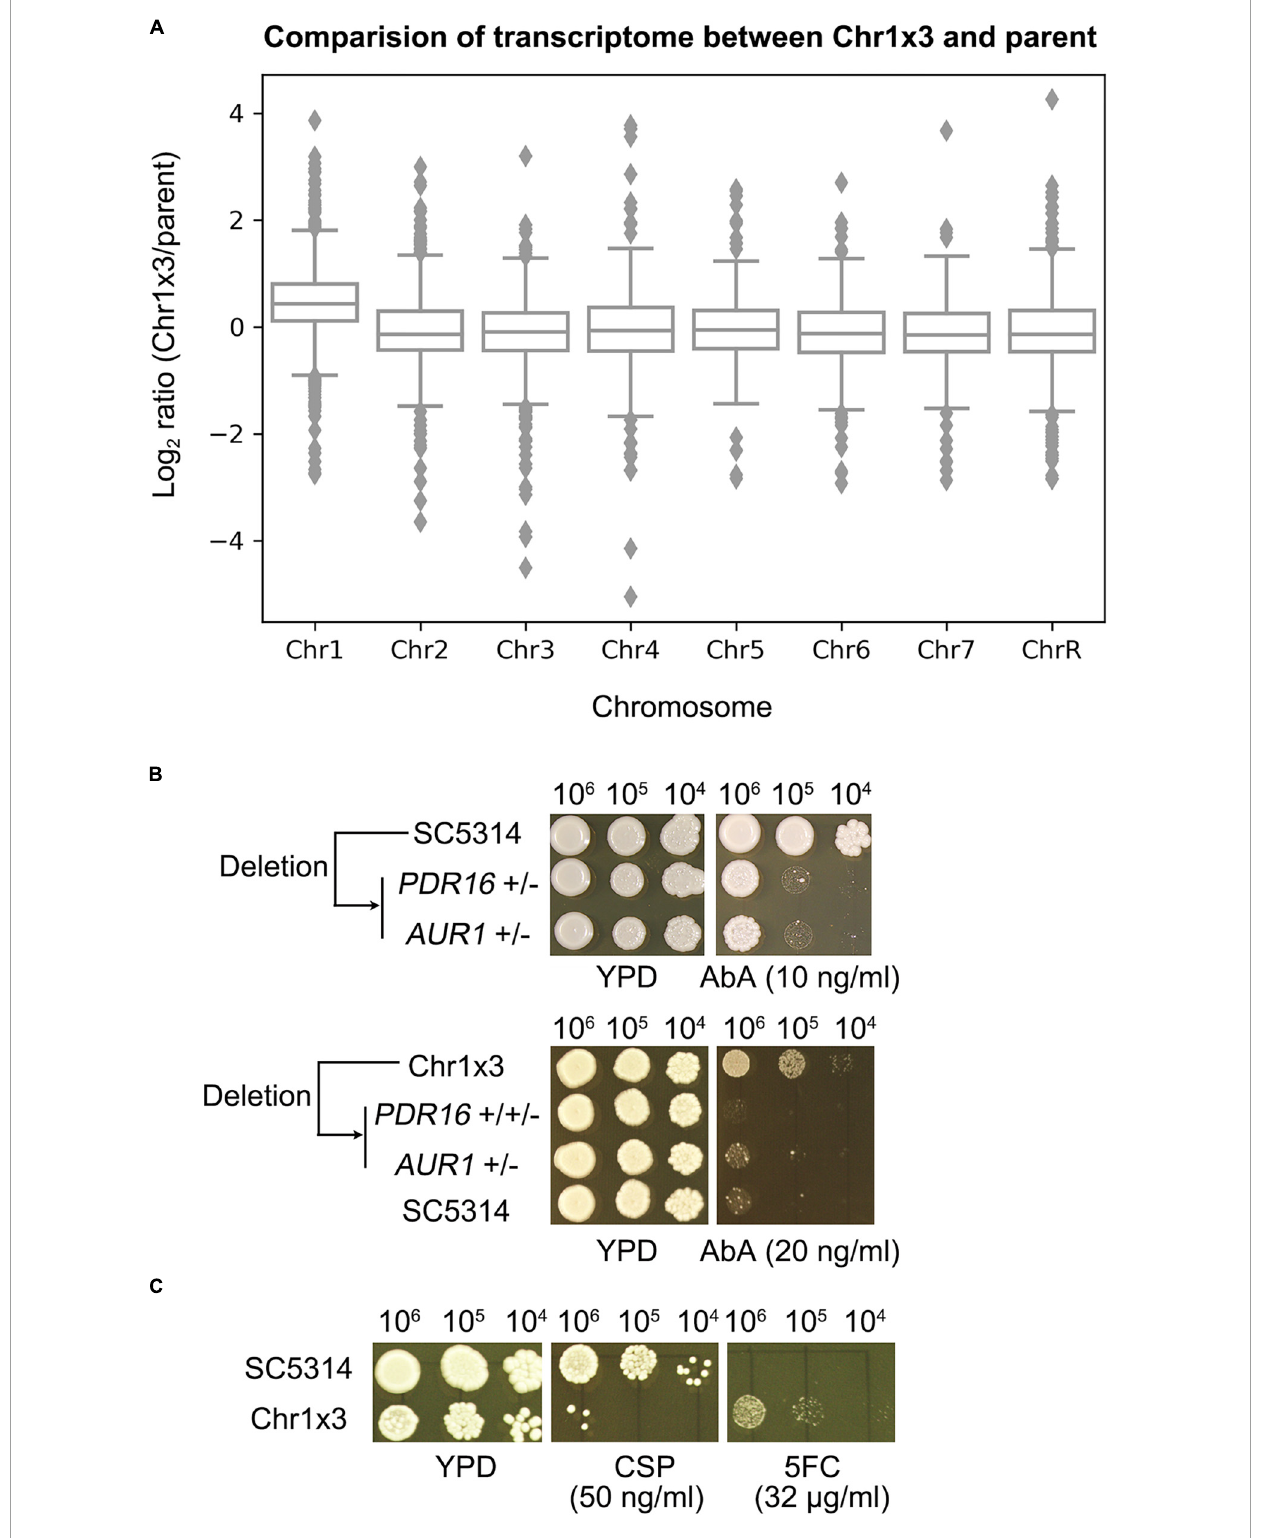
FIGURE4 Chromosome 1 trisomy has pleiotropic effect on whole genome transcription and antifungal resistance profile. Transcriptome of one Chr1 trisomy mutant was compared to the diploid wild type strain. Cells were grown on YPD plates at 37 ◦ C. Log 2 ratio of genes expression levels were plotted as a function of chromosome position (A) . Strains with deletions of one allele of PDR16 or AUR1 were compared to wild type diploid strain parent SC5314, or a Chr1 × 3 parent, for resistance to aureobasidin A (Ab) (B) . Pleiotropic effect of Chr1 trisomy on antifungal resistance was tested by spot assay on YPD plates supplemented with caspofungin (CSP) or 5-flucytosine (5FC) (C) . In panels (B,C) , the plates were incubated at 37 ◦ C for 48 h then